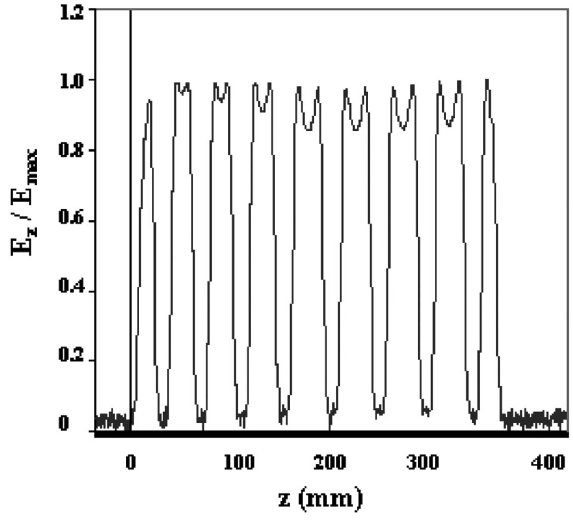
FIG. 6. Computed energy distribution.FIG. 5. Electric field distribution on the z axis.